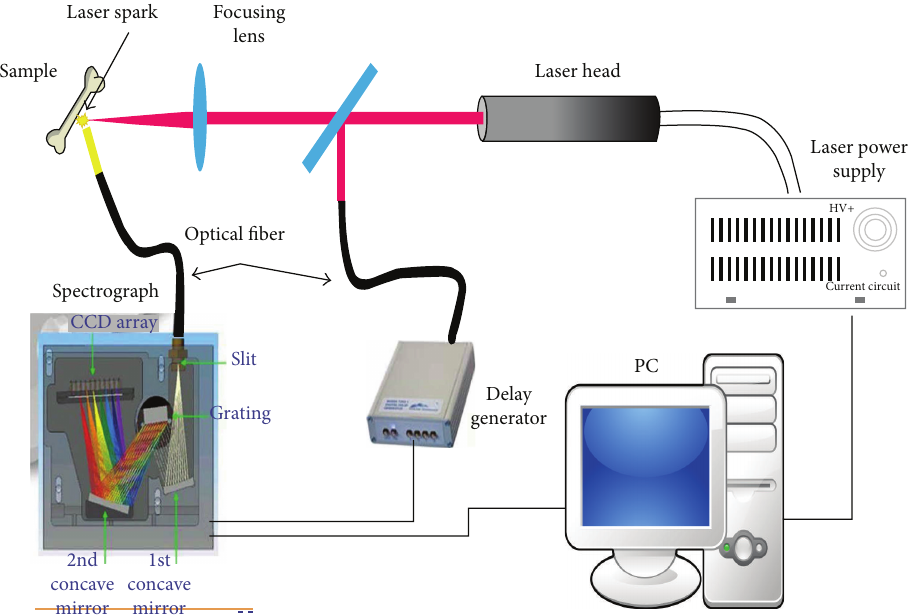
Figure 1: Schematic of the LIBS setup.